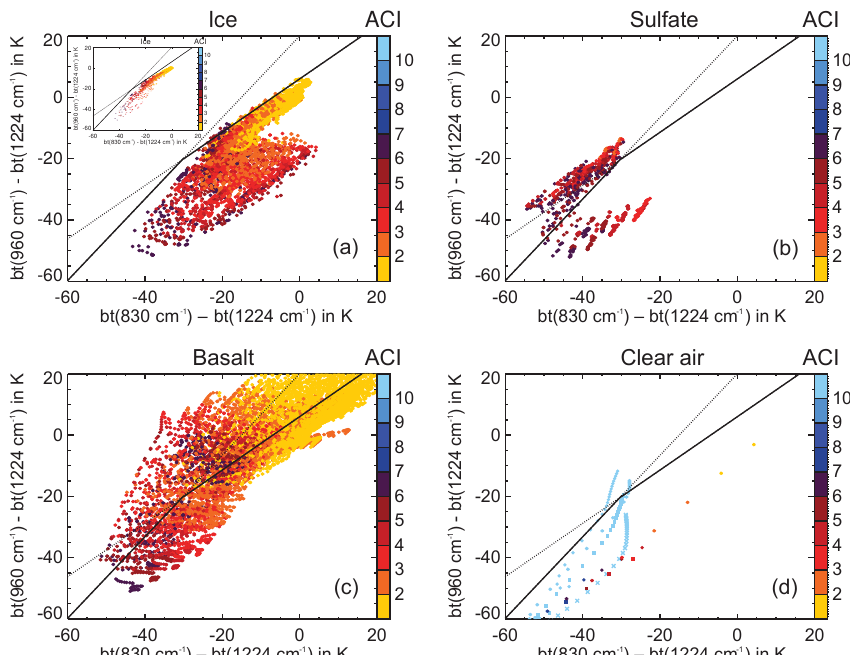
Figure 4. Simulated brightness temperature difference correlations for (a) ice clouds, (b) sulfate aerosol, (c) volcanic ash (here basalt from Pollack et al. (1973) is shown), and (d) clear air. The ice cloud simulations are shown for mode radii ranging from 0.3 to 96µm. In the small inset ice simulations are only shown for mode radii ranging from 12 to 96µm. For the clear air simulations the atmosphere type is indicated by the following symbols: polar winter – crosses; polar summer – diamonds; midlatitudes – squares; equatorial – circles. The black lines are the ice separation thresholds, where the solid part of each line denotes the relevant part for the discrimination between aerosol and ice.